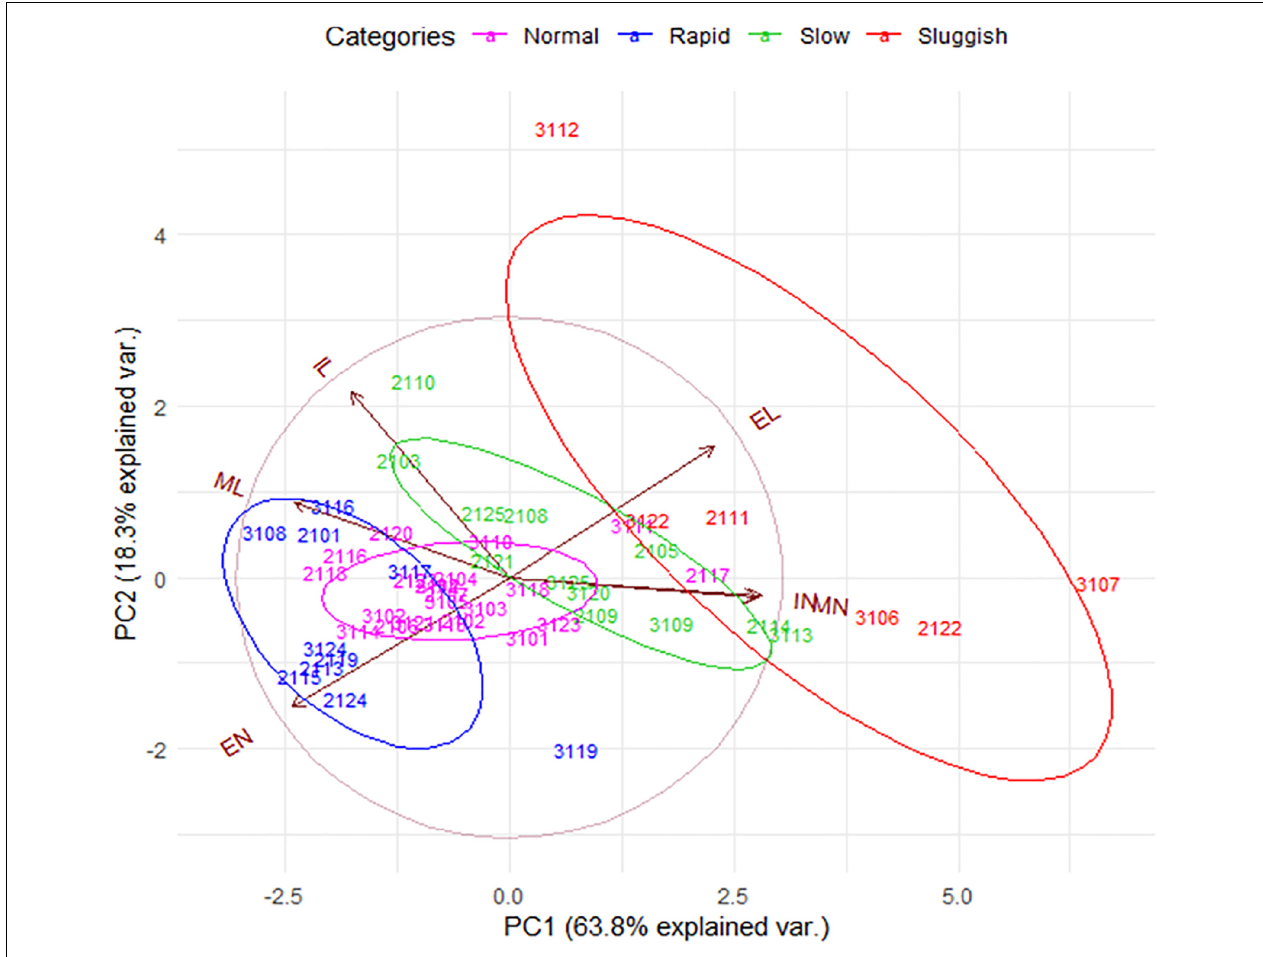
FIGURE 3 | The internal consistency of the presumed EL-ejaculatory endophenotypes is compromised by introducing the entire set of copulatory parameters to phenotype copulating males. Principal component analyses biplot that allowed us to evaluate the internal consistency of the presumed EL-ejaculatory endophenotypes after introducing all copulatory parameters as covariates of phenotyping. Notice that the way copulatory parameters interact one another per copulating male rat tends to be similar regardless of the EL-ejaculatory phenotype each were assigned to. This circumstance leads to a distribution characterized by a strong overlapping of copulating male rats assigned to either of the presumed EL-ejaculatory endophenotypes; most of them share the same space in the graph (gray circle). The exception being a handful of sluggish copulating males. However, the phenotypic variation among them is so high, that envisioning them as representing true endophenotypes is untenable; they might be better seen as outliers. Also notice that 82.1% of the population variance was explained by PC1 and PC2. Copulating male rats assigned to the presumed EL-ejaculatory endophenotypes are numbered and color-coded differentially; the color-key is placed at the upper edge of the PCA biplot. Copulating male rats assigned to the same ejaculatory endophenotype are enclosed by elliptical traces of the same color; the greater the ellipse area, the highest the estimated intra-categorical variability. Vectors represent copulatory parameters; the closer the angle between vectors, the higher their correlation. Complementary information on PCA is showed in Supplementary Figure S5 . PC1: Principal component one; PC2: Principal component two. EL, ejaculation latency; EN, cumulative ejaculation number; IL, intromission latency, IN, cumulative intromission number; ML, mount latency; MN, cumulative mount